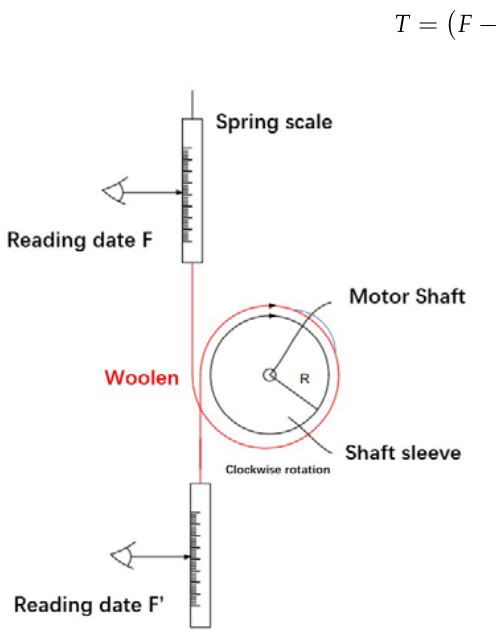
Figure 12. Structure diagram of torque test bench.